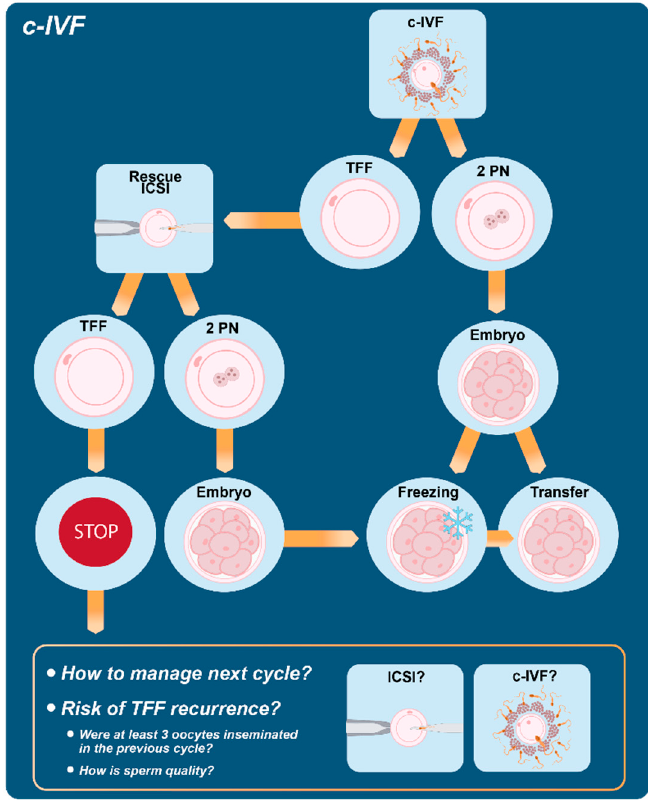
Figure 1. Flowchart describing possible hindrances and solutions related to c-IVF procedure.